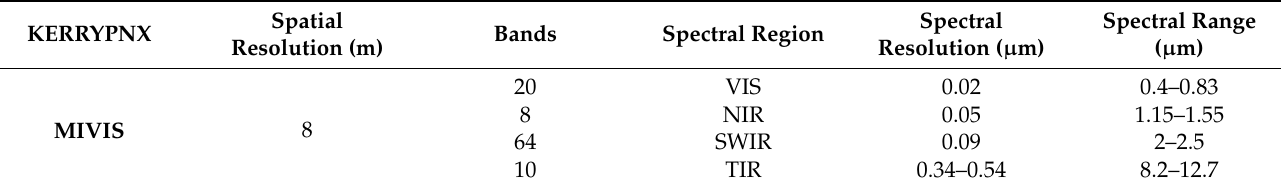
Table 2. Characteristics of the MIVIS